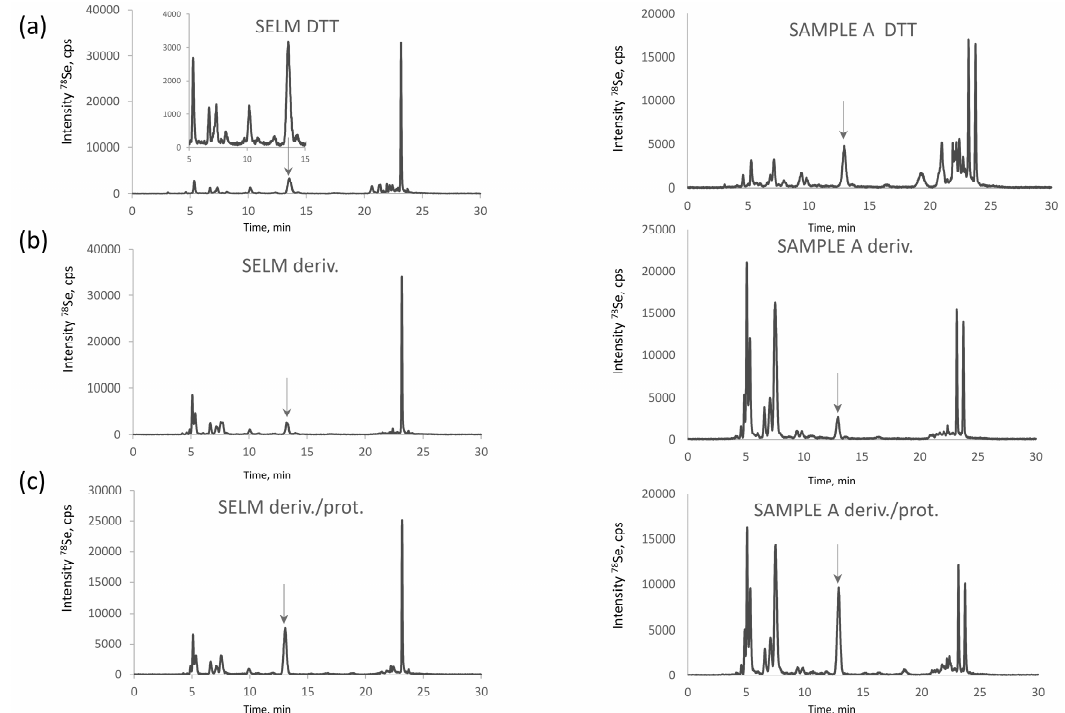
Figure 1. Chromatograms of selenometabolite (water-soluble) selenized yeast fraction ( a ) raw (upon addition of 30 µL of DTT solution); ( b ) derivatized with IAM; and ( c ) derivatized and digested with protease obtained for SELM-1 (left panel) and a commercial selenized yeast sample (right panel).